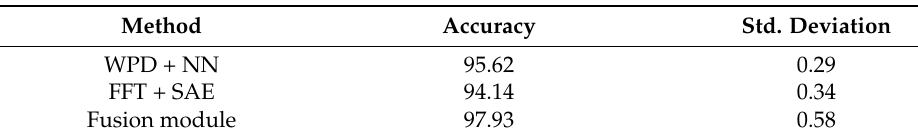
Table 4. The accuracy (%) table comparison with two basic classifiers.